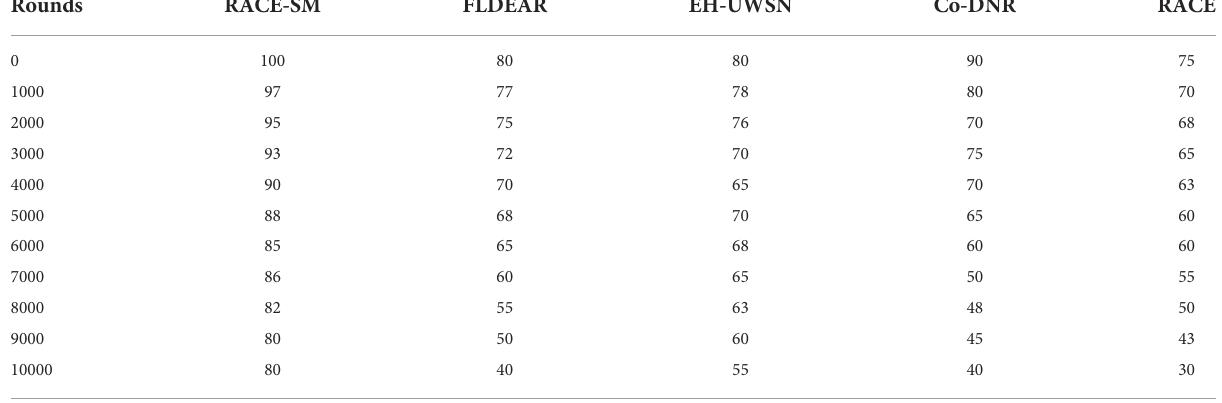
TABLE 3 Protocols addressing PDR.